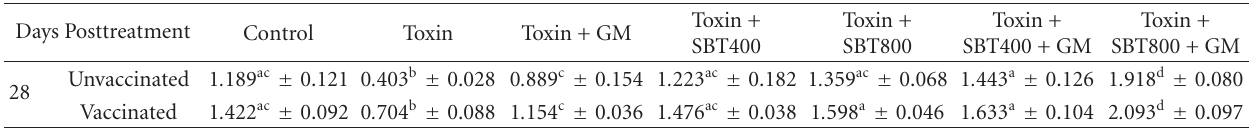
Table 2: E ff ect of dietary supplementation of seabuckthorn berries (SBT) and glucomannan (GM, mycotoxin binder) on total immunoglobulin (g/dl) in birds fed with T-2 toxin.